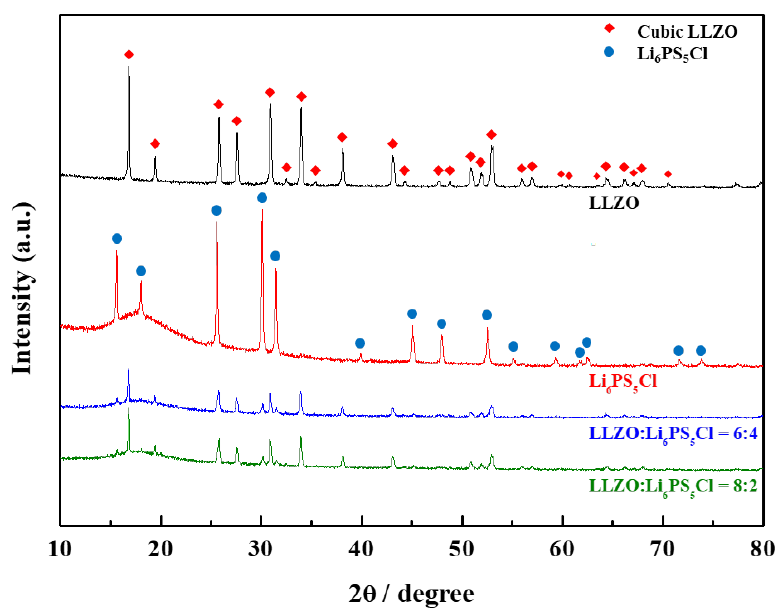
Figure 1. XRD patterns for LLZO, LLZO-LPSC composite, and LPSC electrolytes.